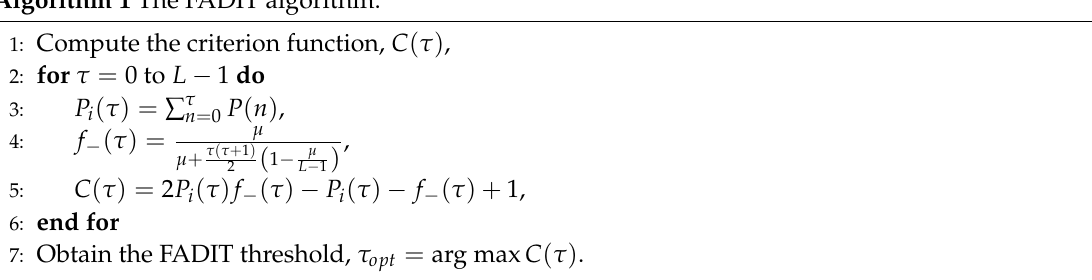
Algorithm 1 The FADIT